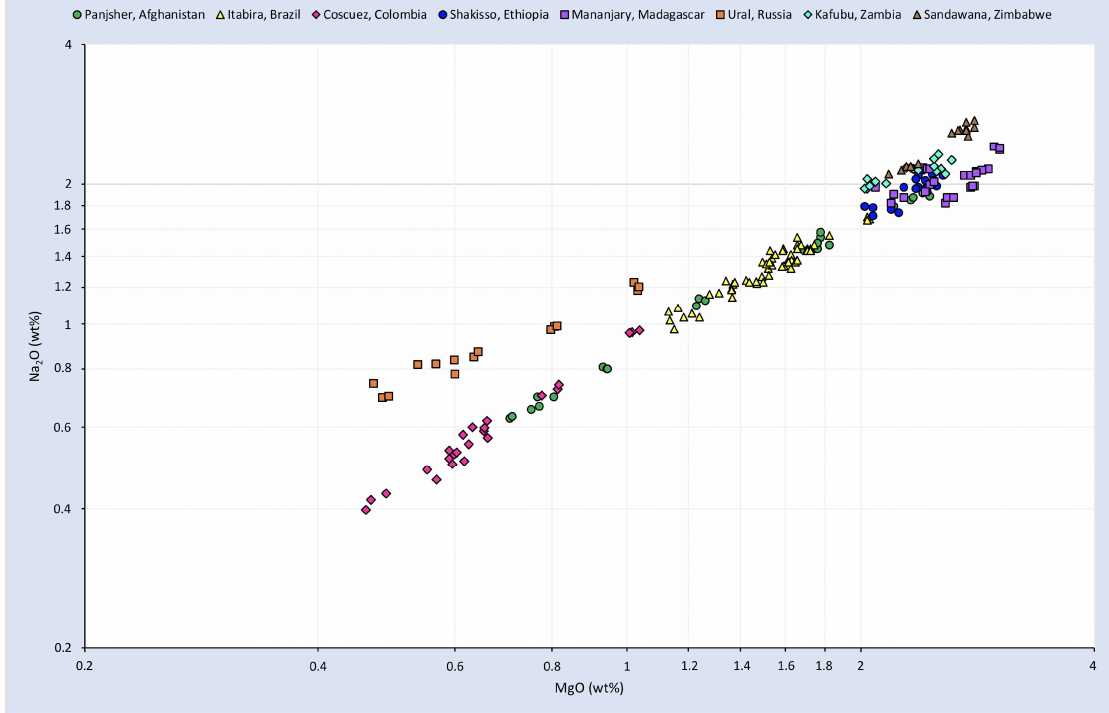
Figure 1. Binary plot of MgO (wt %) vs. Na 2 O (wt